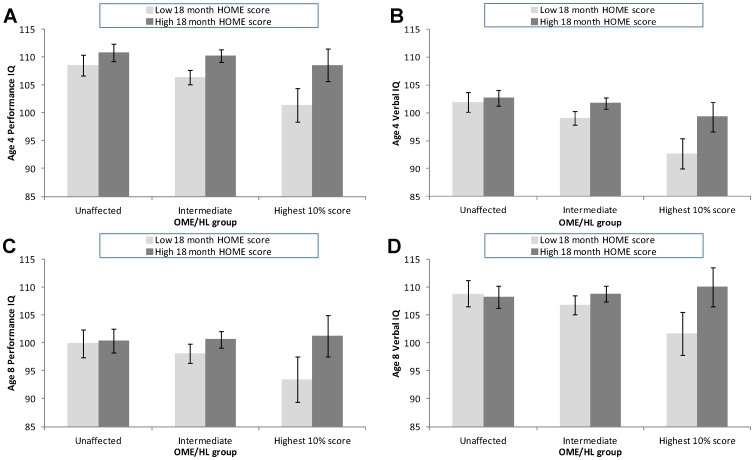
Adjusted mean IQ (95% CI) according to OME/HL group and 18 month HOME scores.A) Performance IQ at 4 years. B) Verbal IQ at 4 years. C) Performance IQ at 8 years. D) Verbal IQ at 8 years. Bottom 50% HOME scores: light grey bars; top 50% HOME scores: dark grey bars (HOME score groupings are for illustration only; statistical analyses use the raw HOME scores). Mean scores adjusted for maternal education level, housing tenure, parental social class, maternal age, parity, smoking during 1st three months of pregnancy, smoking last two weeks of pregnancy, birthweight, gestational age, sex of child. There was evidence of an interaction between OME/HL and HOME scores such that those children with poor scores on both measures performed much worse than other groups (p for interaction in adjusted model using linear scores: p = 0.008 (A), p = 0.001 (B), p = 0.006 (C), p = 0.008 (D)).